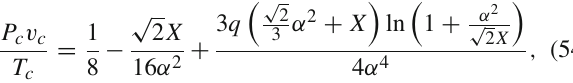
= 0 . 04104 , P = 0 . 002943 ) . We plot the behavior ( T c c between the pressure and horizon in Fig. 2. The tempera- ture of the isothermal lines decreases from top to bottom. The two upper dotted lines are for T > T c correspond